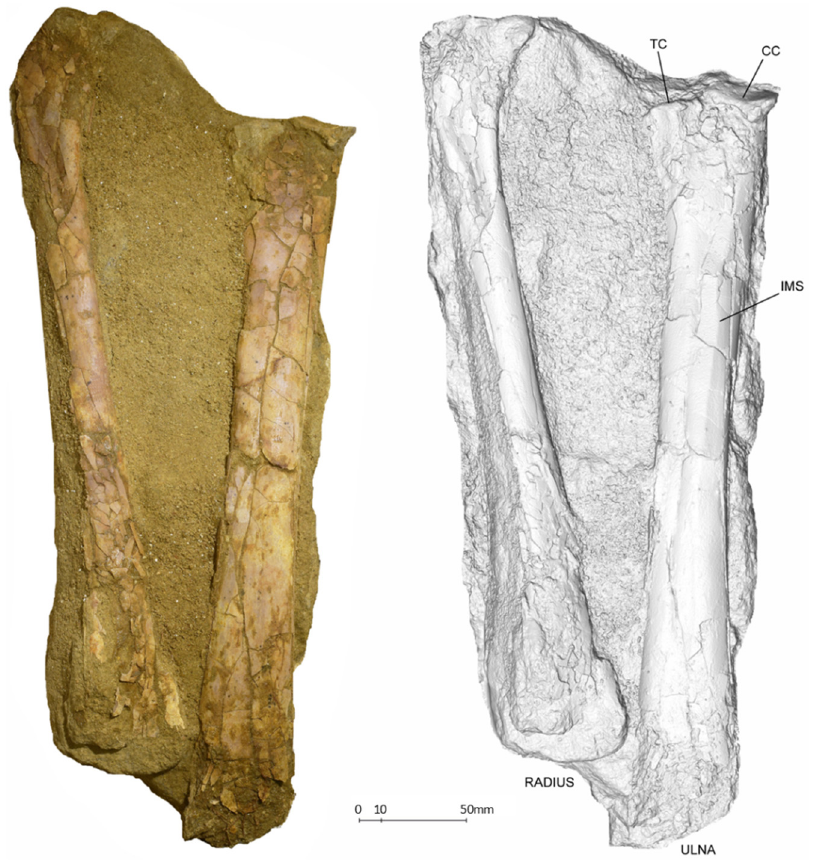
Figure 5. Paratype MGUAN-PA661 Epapatelo otyikokolo gen. et sp. nov. left ulna and left radius. In anterior view. Abbreviations: CC, dorsal cotyle; TC, ventral cotyle; IMS, interosseous membrane scar.